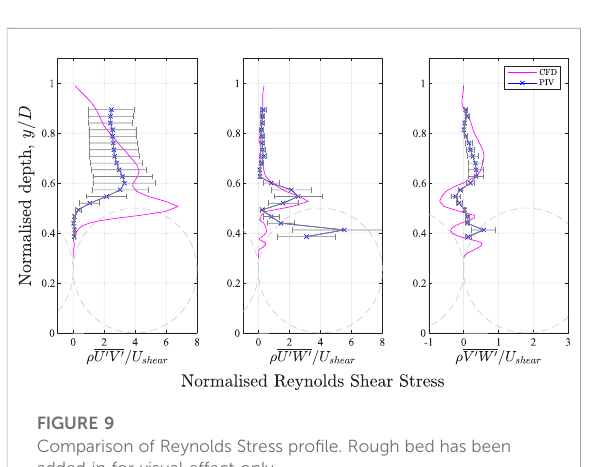
FIGURE 9 Comparison of Reynolds Stress pro fi le. Rough bed has been added in for visual effect only.